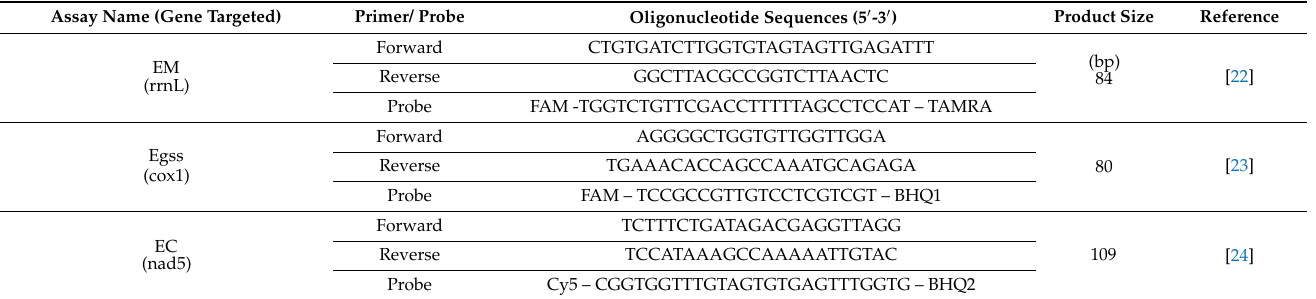
Table 1. Description of the different primers and probes used in three separate qPCR to detect E. multilocularis (EM), E. granulosus s.s. (Egss) and E. canadensis